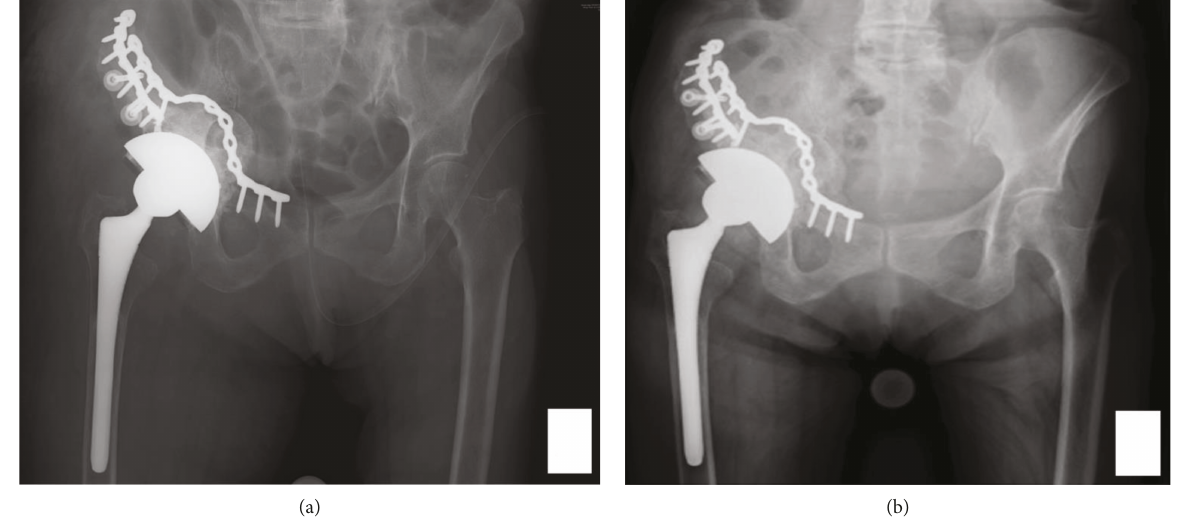
Figure 3: Postoperative radiograph at immediately after surgery (a) and at fi nal follow-up